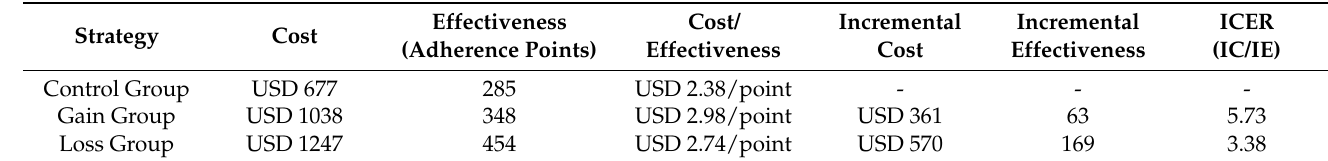
Table 6. Costs, Effectiveness, and Cost-Effectiveness of Loss, Gain, and Control Groups Relative to